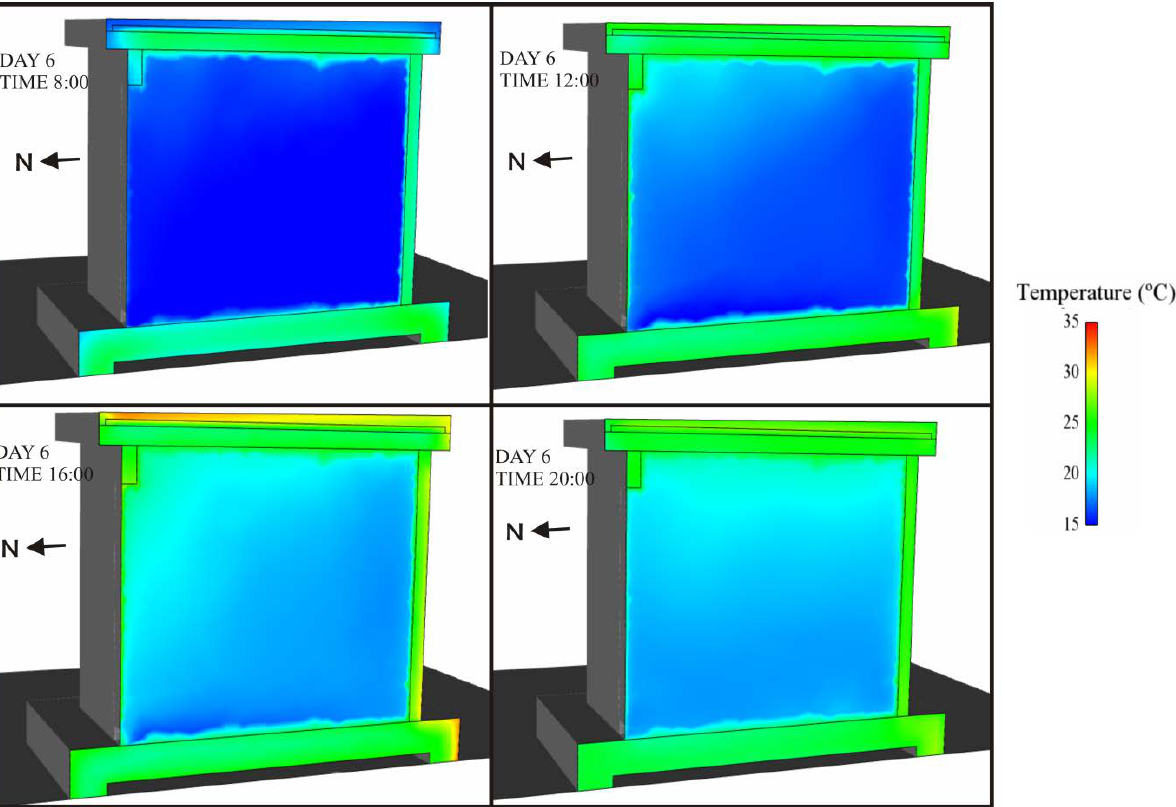
Figure 15. Evolution of the temperature field inside the cubicle and inside the walls in the PCM simulation.